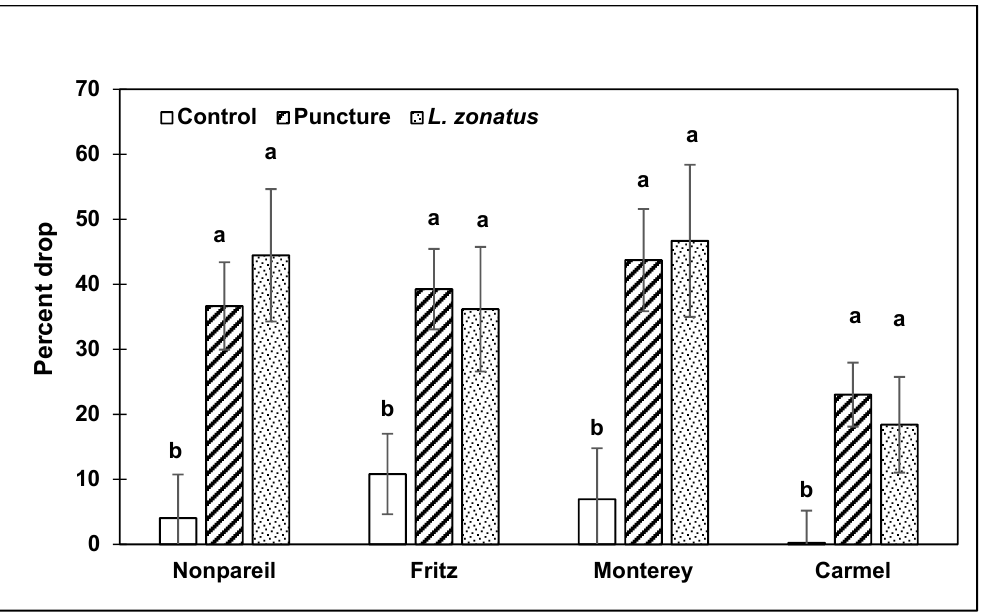
Figure 1. Mean (± SE) almond drop in four experimental treatments in four almond varieties in 2014. Within each variety, there was a significant difference among treatments (Kruskal–Wallis). Pairwise comparisons were by Steel–Dwaas tests ( p < 0.05), and significant differences are indicated by different letters.